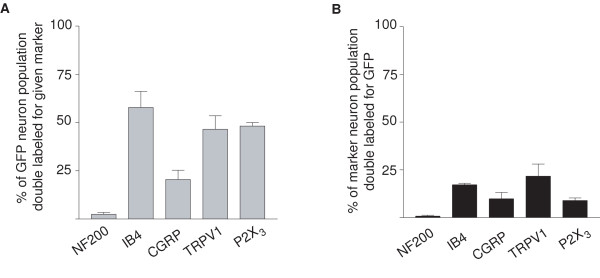
Summary of GFP expression in DRG sensory neuron subpopulations in Pde1c BAC transgenic mice. (A) The percentage of GFP-Pde1c expressing cells double labeled for a given marker. (B) The percentage of a given DRG sensory neuron subpopulation double labeled for GFP-Pde1c. Data are mean ± SEM (n = 3)